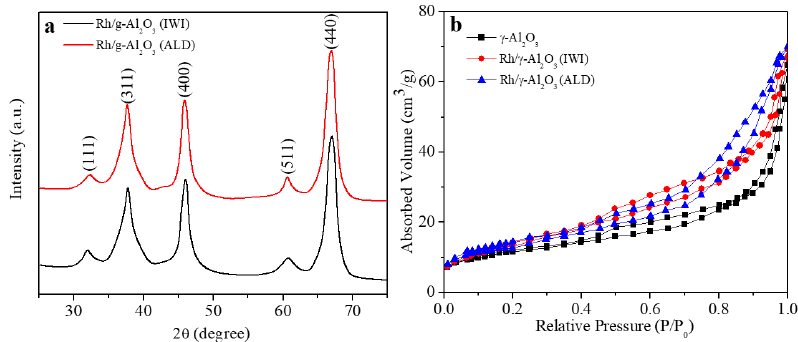
Figure 5. ( a ) XRD patterns of Rh/ γ -Al 2 O 3 catalysts from ALD and IWI; ( b ) N 2 adsorption/desorption